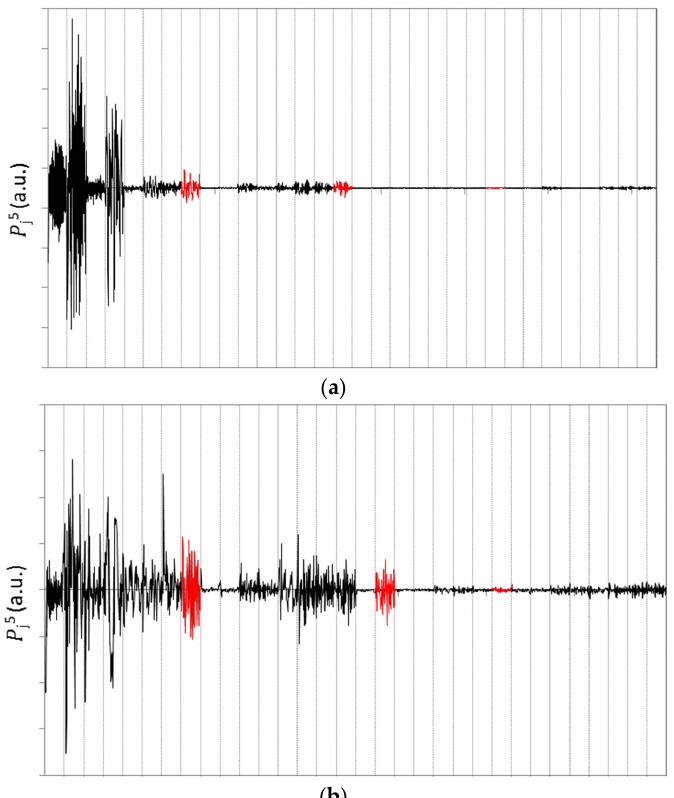
Figure 5. Wavelet packet coefficients associated with all the nodes on 5th resolution of the wavelet packet tree for above process-orientated AE burst ( a ) and AE burst indicating damage ( b ).